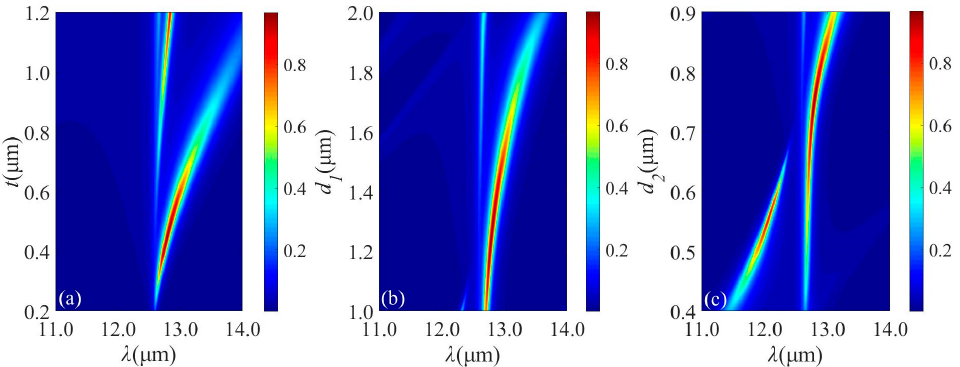
Figure 4. ( a ) Emission spectra of SiC film with different t under normal incidence for TM polarization when d s = 0.75 µ m, d 1 = 1.25 µ m and d 2 = 0.75 µ m with 5 DBR pairs. ( b ) Emission spectra with different d 1 under normal incidence for TM polarization when t = 0.45 µ m, d s = 0.75 µ m and d 2 = 0.75 µ m with 5 DBR pairs. ( c ) Emission spectra with different d 2 under normal incidence for TM polarization when t = 0.45 μ m, d s = 0.75 μ m and d 1 = 1.25 μ m with 5 DBR pairs.